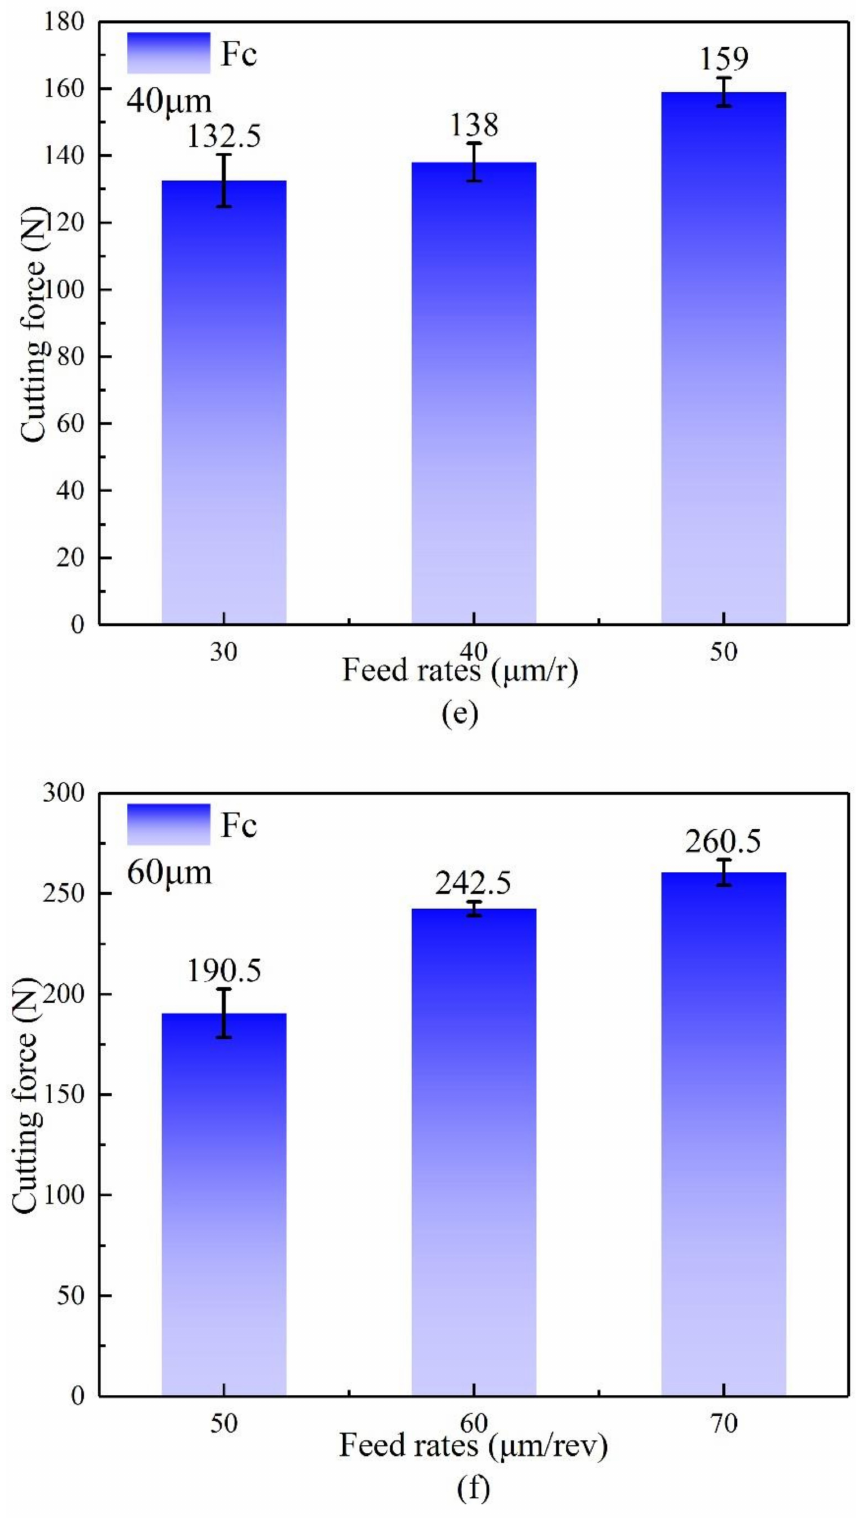
Figure 5. The cutting forces at different feeding rates. ( a – c ) Cutting forces Fp of Grain size = 30 µ m, 40 µ m, 60 µ m, respectively; ( d – f ) Cutting forces Fc of Grain size = 30 µ m, 40 µ m, 60 µ m,